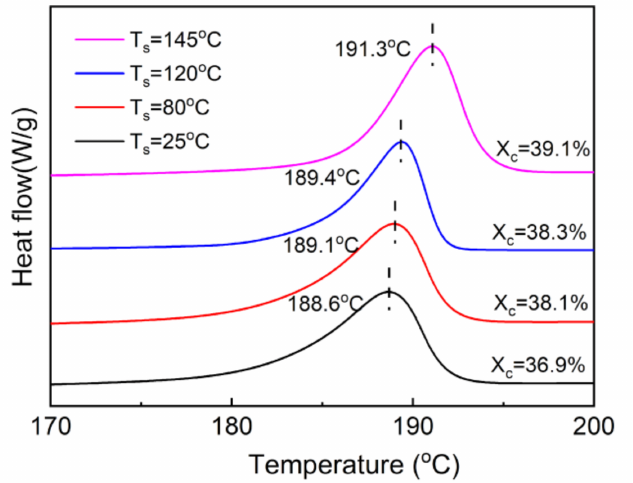
Figure 5. XRD fitting curves for the diffraction peaks of the stretched nylon-11 films with different temperatures. ( a ) 25 ◦ C; ( b ) 80 ◦ C; ( c ) 120 ◦ C; ( d ) 145 ◦ C.